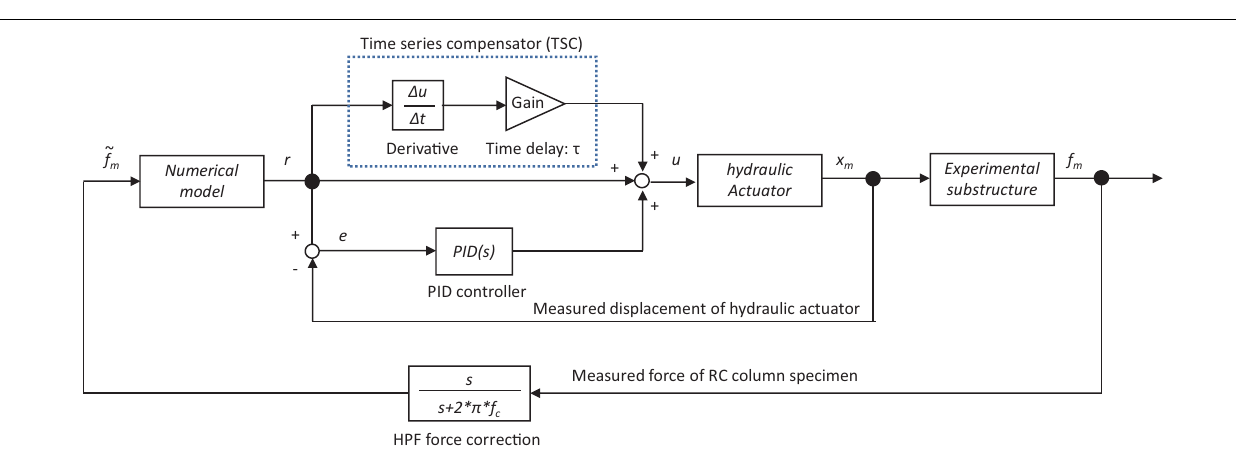
0.046 s without compensation, is reduced to about 0.014 s